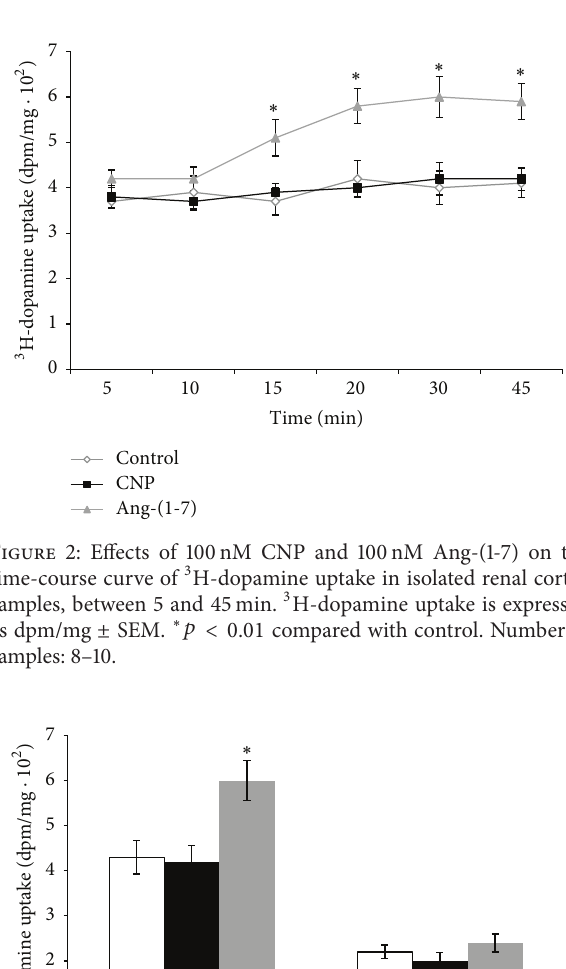
Figure 5: Effects of 100 nM CNP in the presence of 100 nM anantin or 100 nM cANP (4-23-amide) on 3 H-dopamine uptake in renal cortex. 3 H-dopamine uptake is expressed as dpm/mg ± SEM. Number of samples: